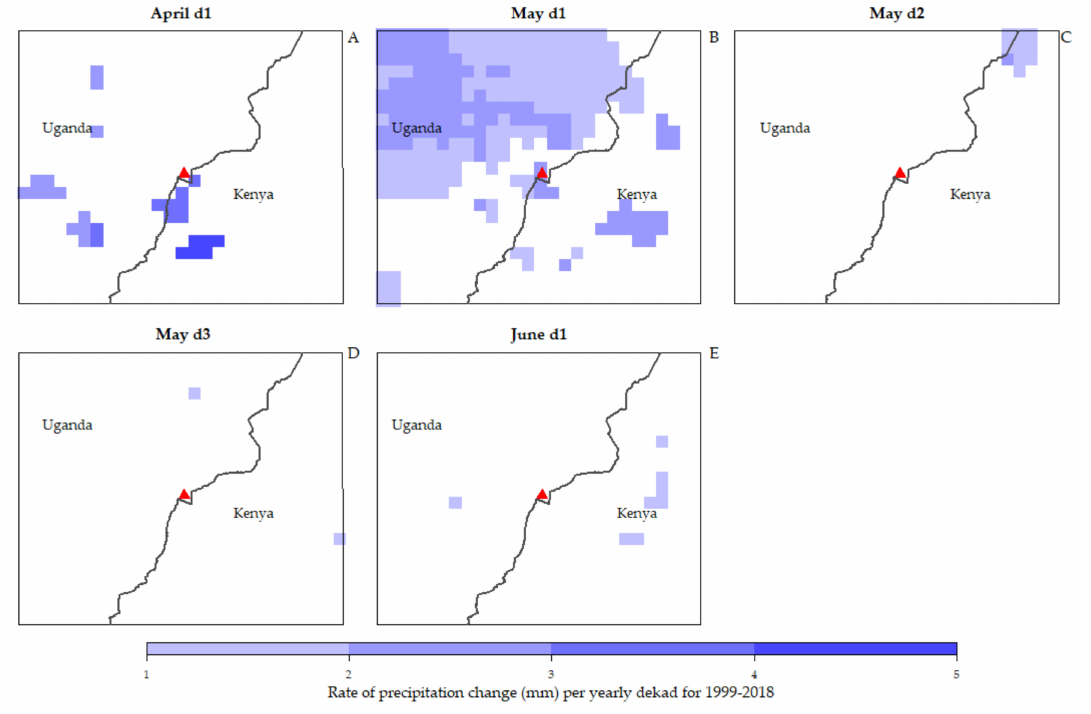
Figure 8. ( A – E ) Significantly changed precipitation for dekads in the period 1999 to